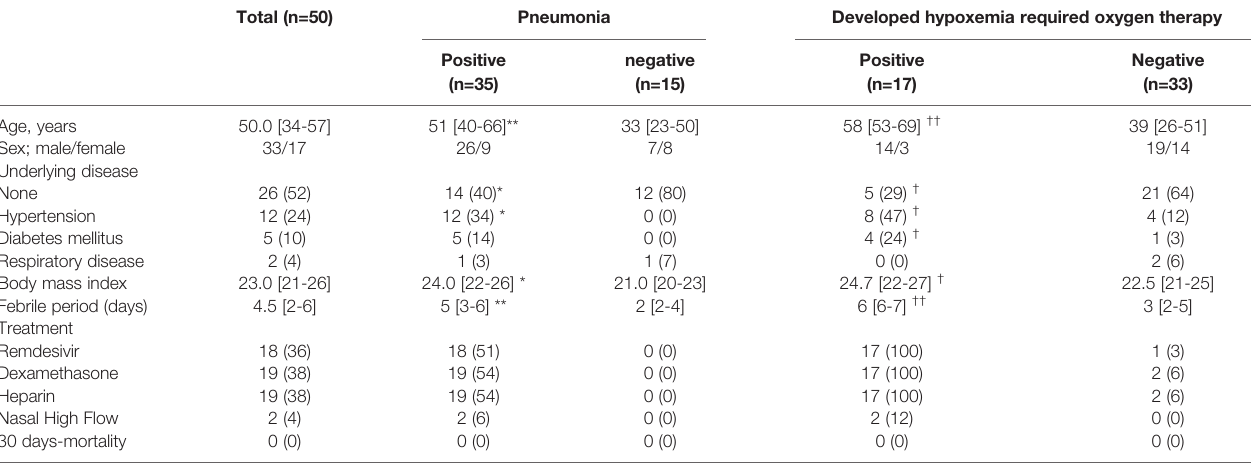
TABLE 1 | Clinical feature of patients in the